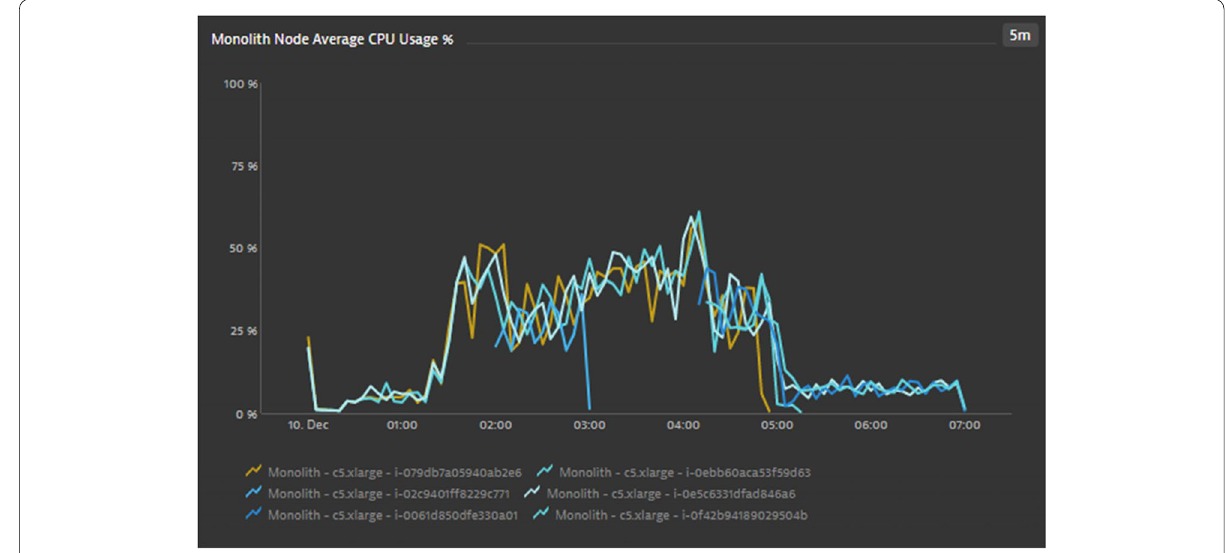
Fig. 17 Average CPU utilization per node, monolithic architecture